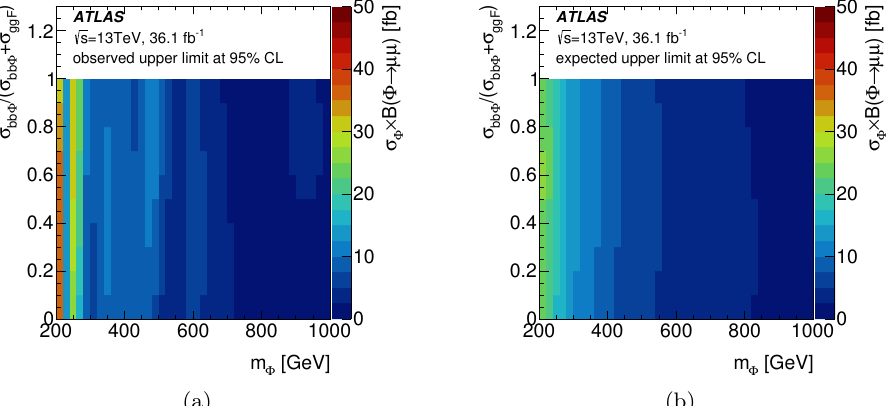
Figure 5 . The (a) observed and (b) expected 95% CL upper limit on the production cross section times branching ratio for (cid:8) ! (cid:22)(cid:22) as a function of the fractional contribution from b -quark associated production and the scalar boson